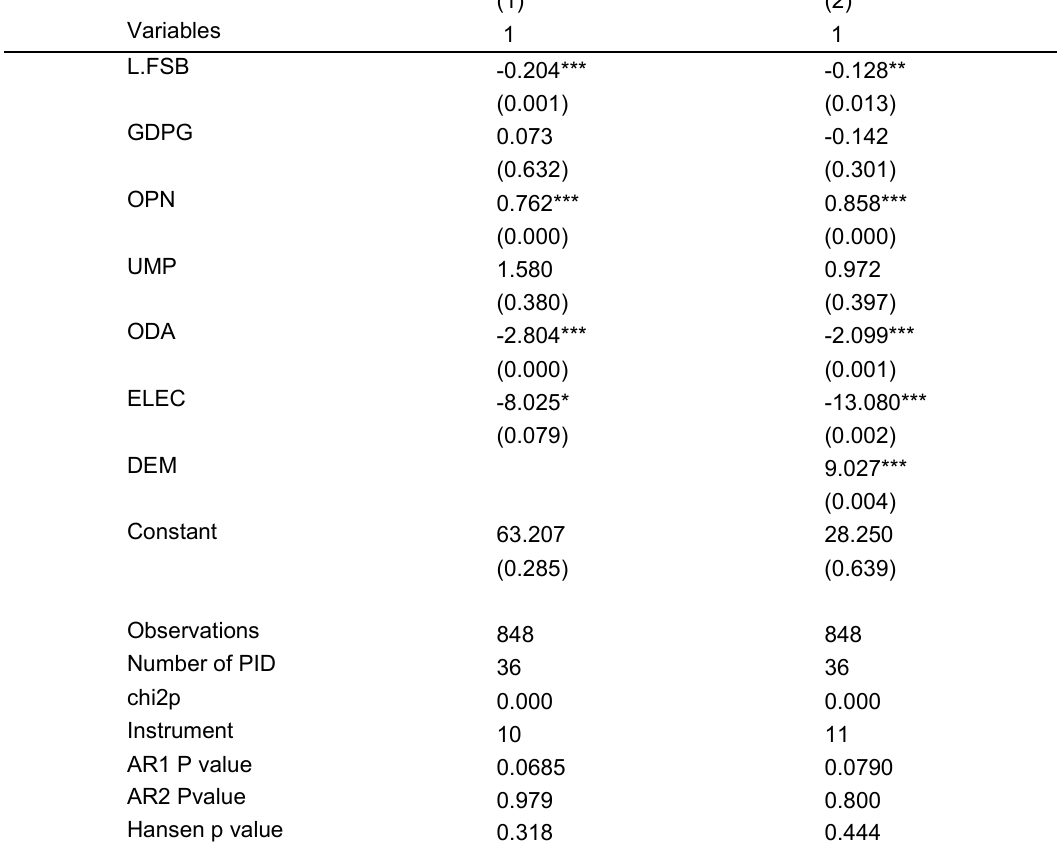
Table 3 . Estimated System GMM Dynamic Panel Regression Results with Election